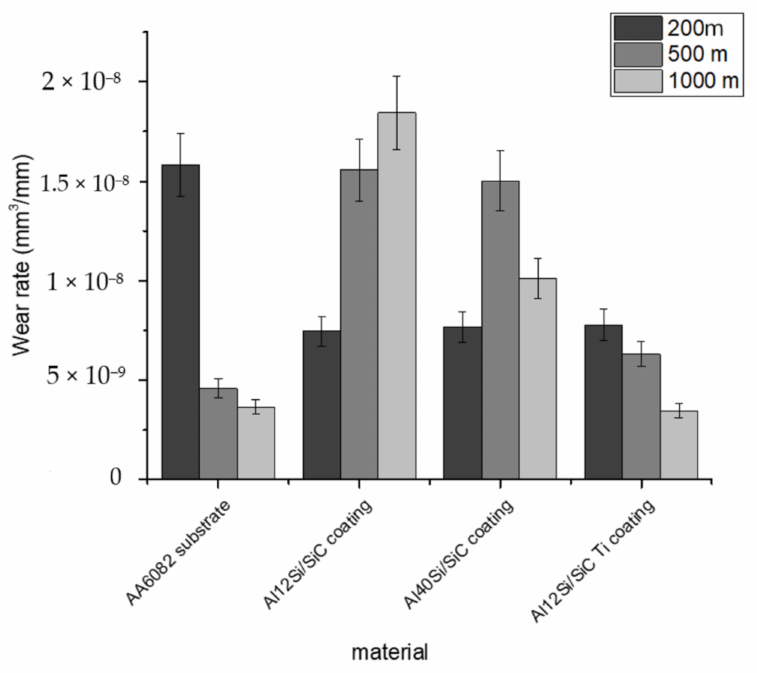
Figure 5. Wear rate for the substrate and coatings on the AA6082 aluminum